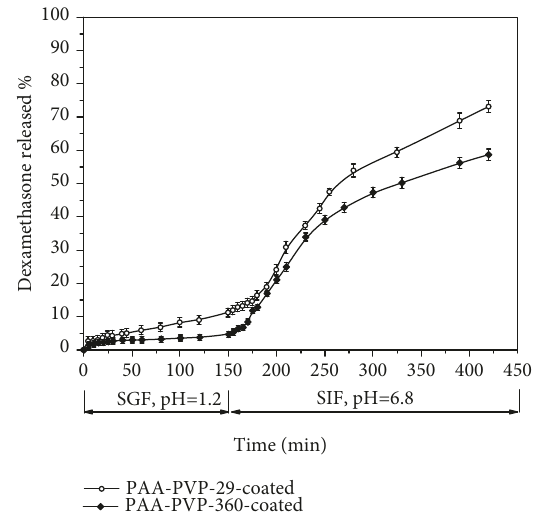
Figure 9: In vitro release pro fi le of dexamethasone from coated loaded CS beads in di ff erent simulated fl uids: simulated gastric fl uid (SGF, pH 1.2) and simulated intestinal fl uid (SIF, pH